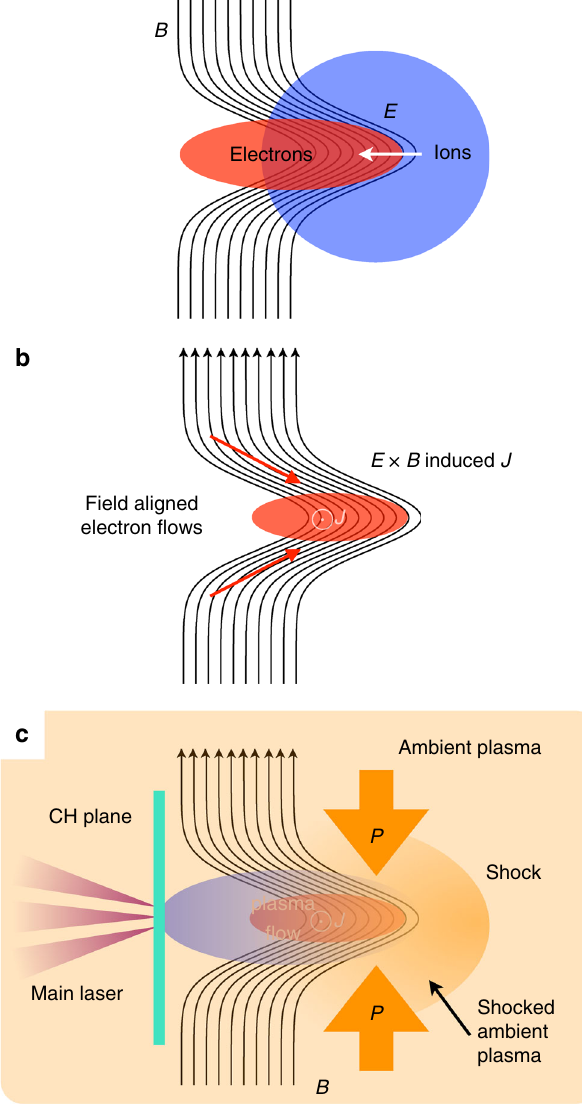
Fig. 2 Model ( a ) A directional plasma fl ow propagates in the presence of a weak-perpendicular magnetic fi eld, where the kinetic energy is much larger than the magnetic energy and only electrons are directly coupled with the magnetic fi eld, resulting in distortion of the magnetic fi led B and the charge separation producing an electric fi eld E . b E × B generated a fi nite electron current J since the ions are not magnetized at this scale. In the distorted fi eld lines, electrons tend to propagate along the magnetic fi eld. This enhances the fi eld distortion and current. c By adding an ambient medium, an external pressure is provided to the plasma fl